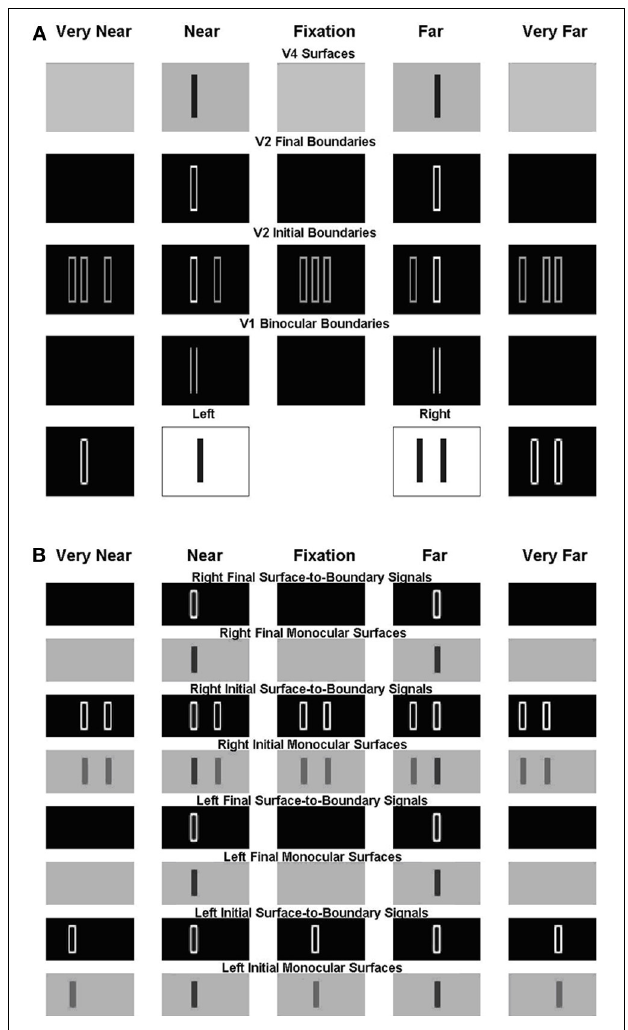
FIGURE 10 | Simulation of dichoptic masking in Panum’s limiting case studied by McKee et al. (1995). See the caption of Figure 6 for an explanation of the variables being simulated, and the text for further